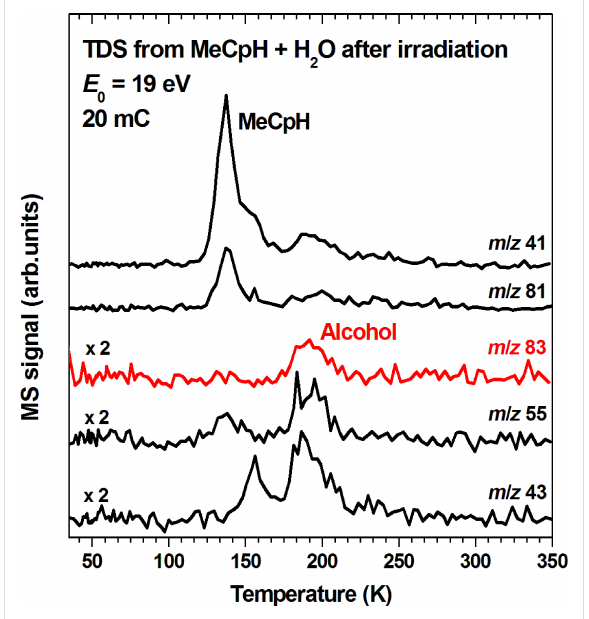
Figure 9: Thermal desorption spectra from a mixed condensed layer of MeCpH and H 2 O (1:1) with estimated thickness corresponding to 20 monolayers on a Au substrate recorded after an electron exposure of 4 mC/cm 2 at E 0 = 19 eV with the substrate held at 35 K. See text and Table 1 for explanations on selection of m / z ratios shown